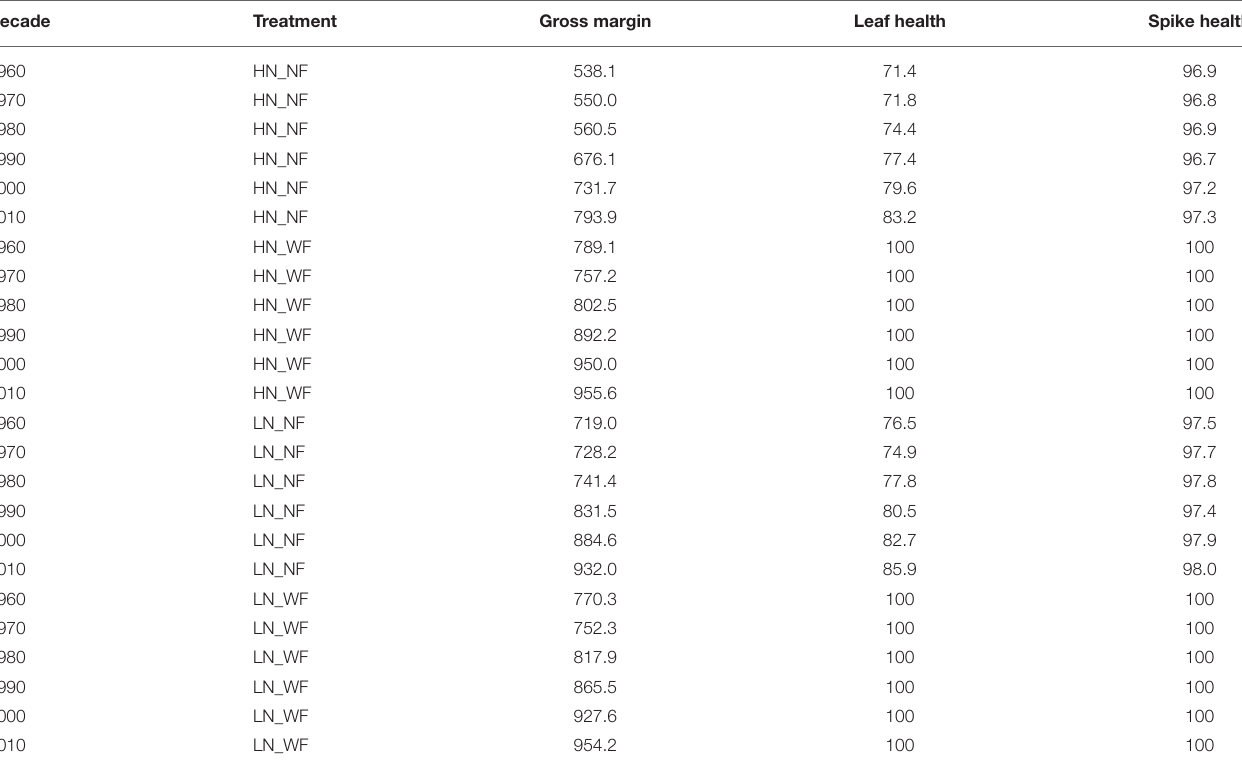
TABLE 5 | Average gross margin (EUR ha − 1 ) and health index per decade and treatment group; Explanation of treatments: high nitrogen application (HN), low nitrogen (LN), no fungicides (NF), with fungicides (WF).